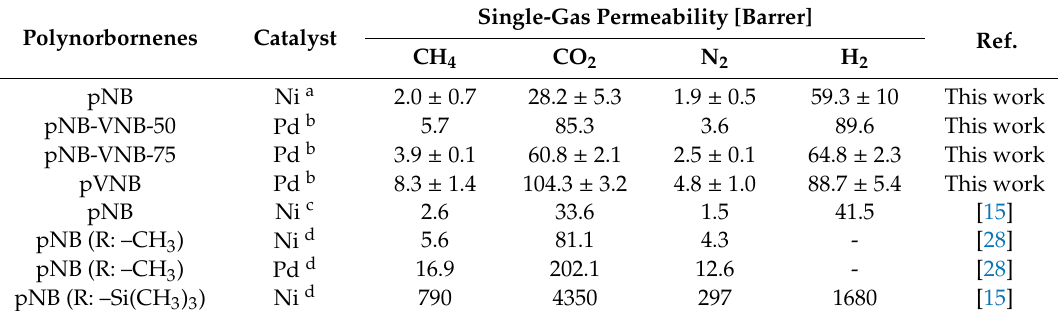
Table 4. Single-gas permeability data of polynorbornenes with increasing VNB content after 100 days of aging and other polynorbornenes with di ff erent side groups (R) performances.